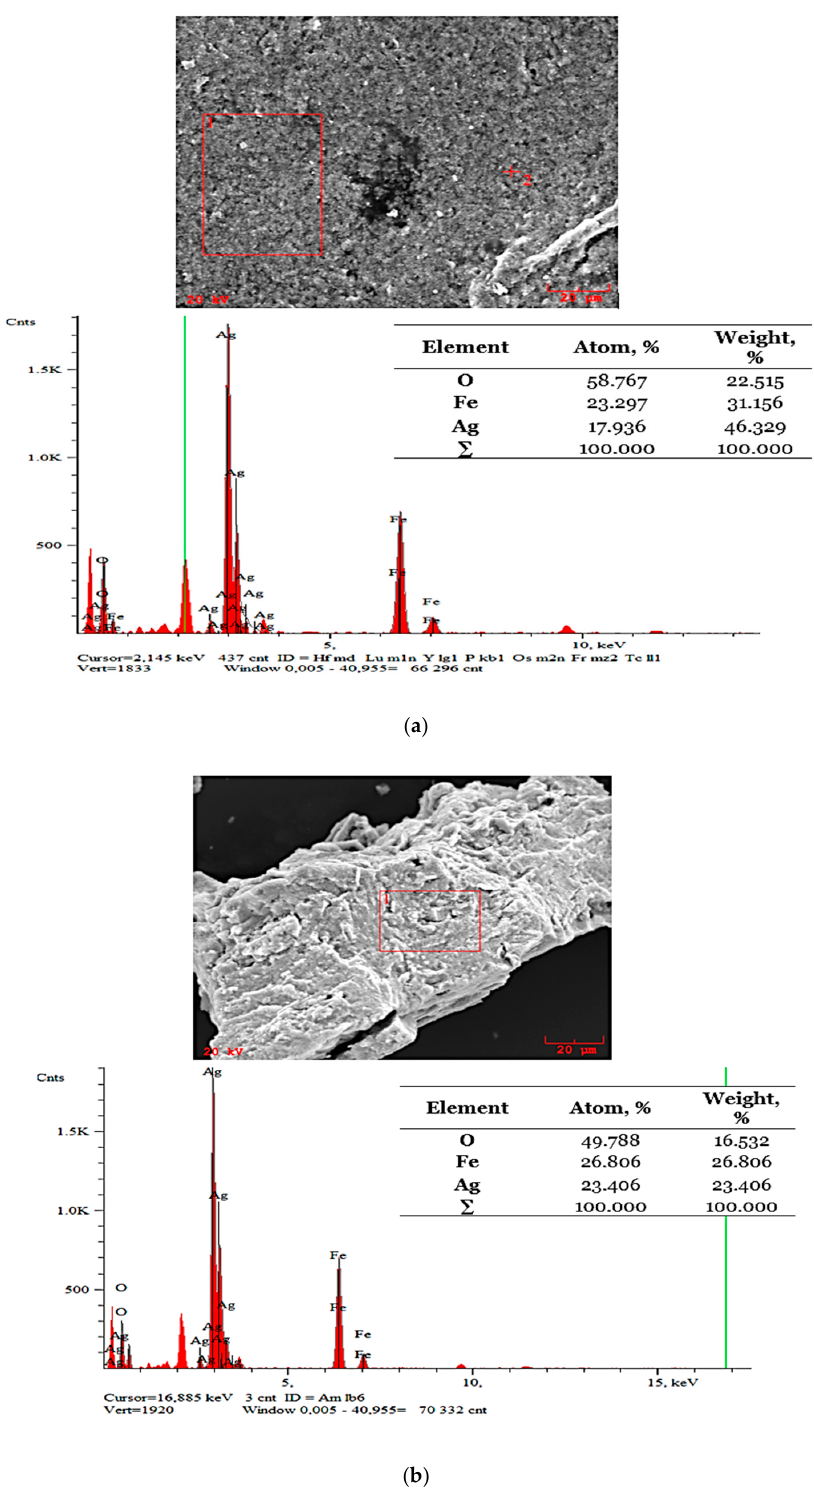
Figure 13. SEM images of the Fe 3 O 4 @Ag nanoparticles supported by an elemental analysis in two points ( a , b ).